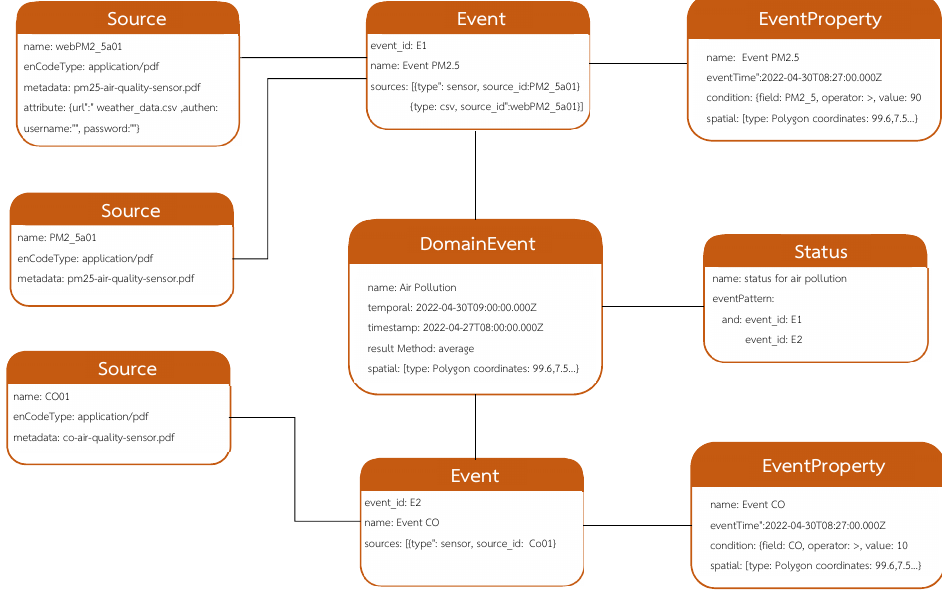
Figure 4. The data modeling scenario in an air pollution